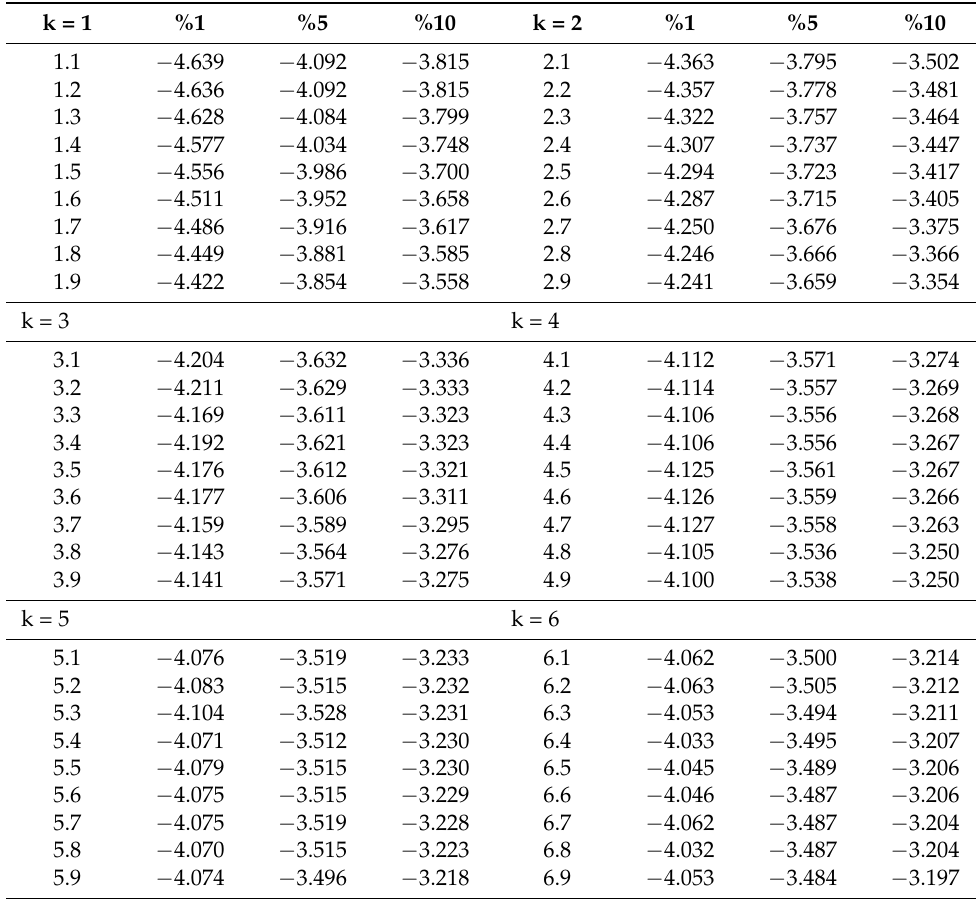
Table 3. Critical values for the two step intercept and trend case.